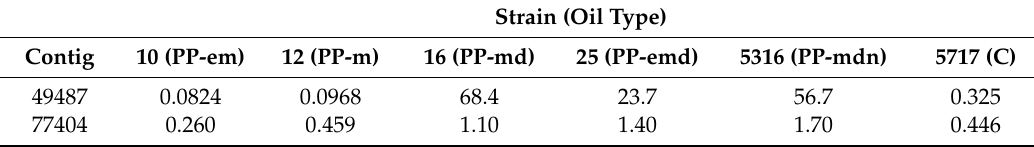
from upstream of the sequence. Black background indicates 100% amino acid identity among the three clones and gray background indicates greater than 50% amino acid identity. Table 1. Reads per kilobase of exon per million mapped read (RPKM) values of contig 49487 and 77404. Oil type C means that the strain mainly contains citral, a monoterpene (MT)-type oil component. Contig 49487 had the largest difference in RPKM values between PP-type strains containing dillapiole (i.e., strains 16, 25, and 5316) and others. Contig 77404 showed the second largest difference in RPKM values.